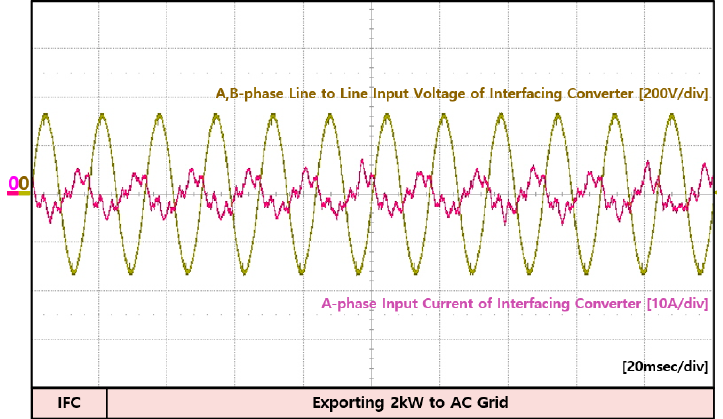
Figure 19. Experiment waveforms of interfacing converter at AC grid in mode 3.